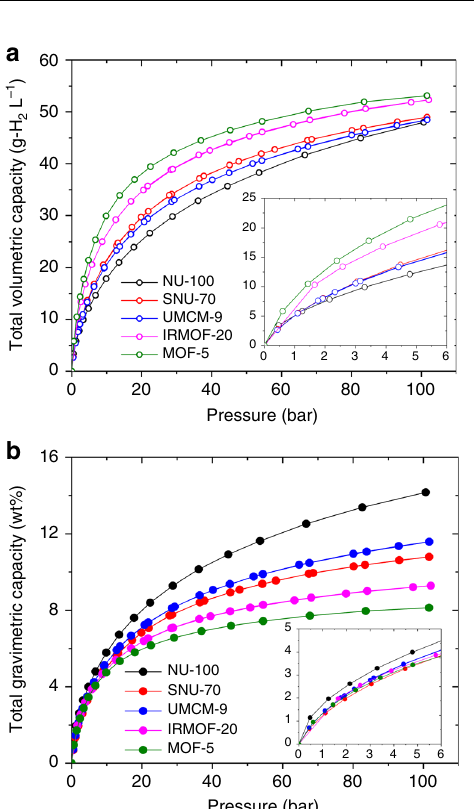
Fig. 3 H 2 adsorption isotherms. Measured total ( a ) volumetric and ( b ) gravimetric H 2 adsorption isotherms of NU-100, SNU-70, and UMCM-9 at 77 K. For comparison, isotherms (ref. 1 ) for the two benchmark MOFs, MOF-5 and IRMOF-20, are also shown. Inset plots illustrate capacities at low